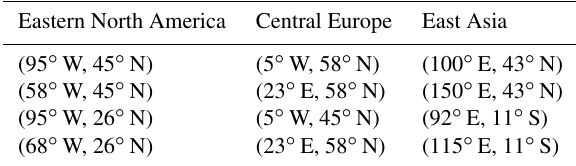
Table 2. Vertices of eastern North America, Central Europe and East Asia denoted by blue boxes in Fig.